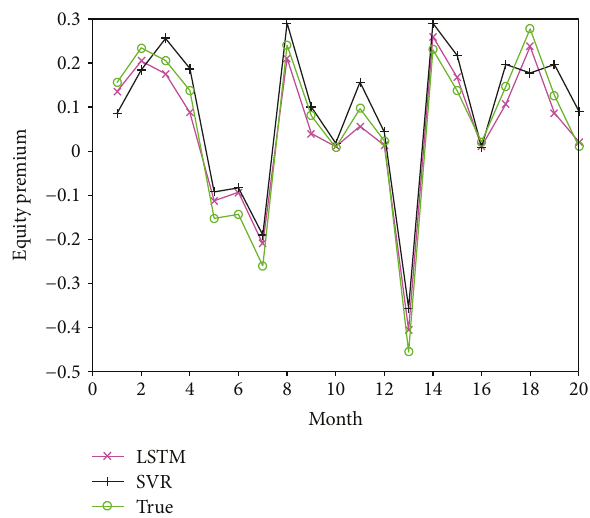
Figure 10: Comparison of SVR and LSTM prediction